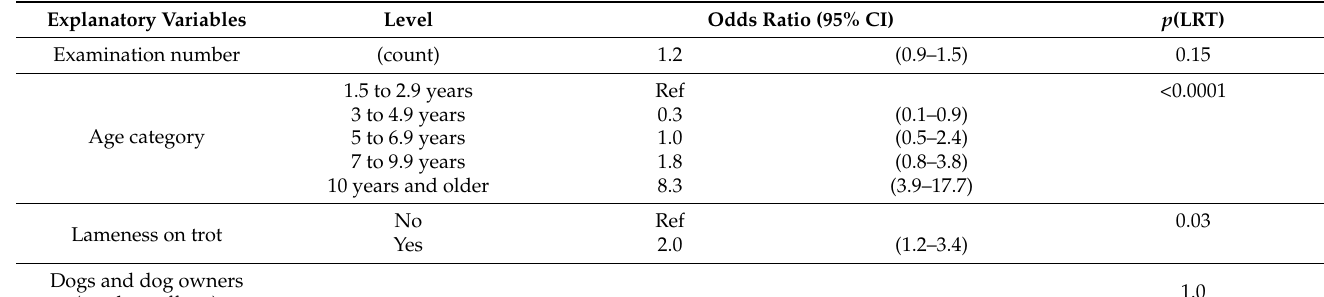
Table 9. Results of the final multivariable logistic mixed model showing the effect of a range of explanatory variables on the risk of examinations being followed by dogs’ dying or being retired. Individual dogs and dog owners were defined as nested random effects. Data used in the final model are from 1360 examinations of 589 dogs, of which 81 examinations were followed by the dog dying, being euthanized or being retired. All dogs were enrolled in the TeamMate